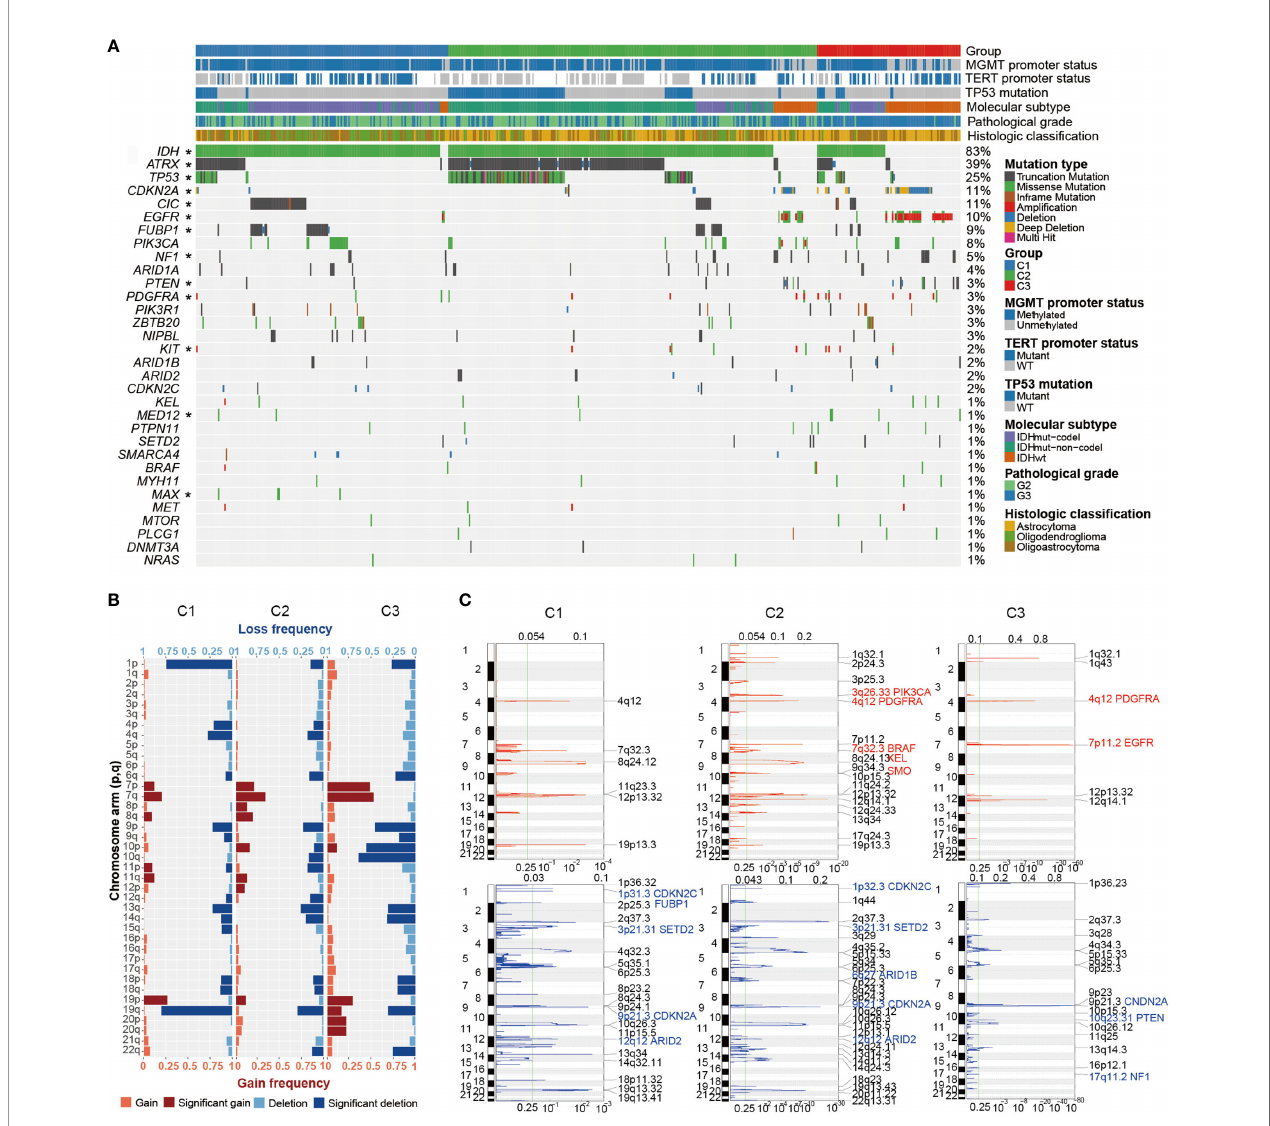
FIGURE 2 | The genomic pro fi le of LGG. (A) Mutational landscape of LGG. LGG samples were subtyped based on the expression spectrum of the Wnt/PCP regulation pathway. Mutation types are color labeled. Signi fi cant enrichments of speci fi c mutations are asterisked at the left side. (B) Landscape of arm-level and focal SCNAs. Recurrent arm-level SCNAs were depicted in each group; the horizontal axis indicates the proportion of samples harboring corresponding arm-level SCNA event, and the vertical axis represents the arm of each chromosome. Both copy number gain (red) and loss (blue) were further classi fi ed into shallow and deep copy number alteration. (C) Recurrent focal SCNAs were depicted in each group. Dashed line marks the q-value threshold of 0.25. Known driver SCNAs are marked with the gene name. *P <